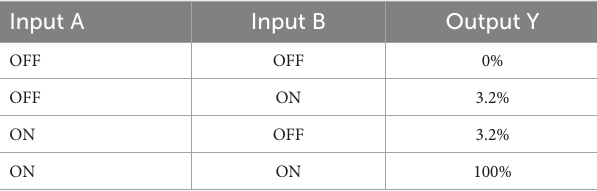
TABLE 1 Effective truth table for the VALVeD input architecture with the behavior of a leaky AND logic gate for analog